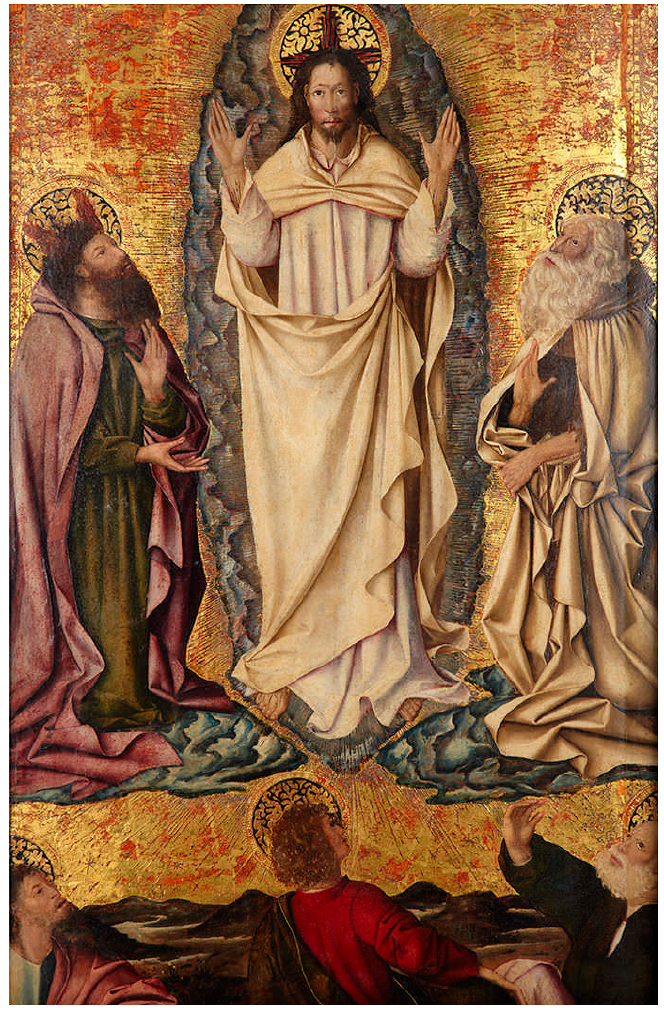
Figure 6. Master of Bonastre (Jacomart, also known as Jaume Baçó?), Transfiguration Altarpiece. Valencia, Museo de la Catedral. Used by permission.